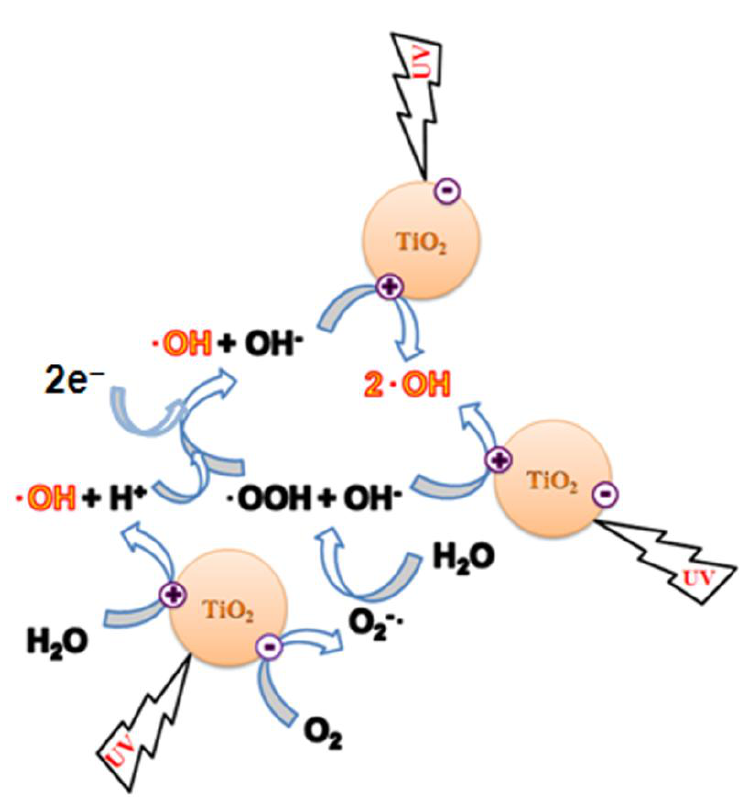
Figure 2. Photocatalytic generation of hydroxyl